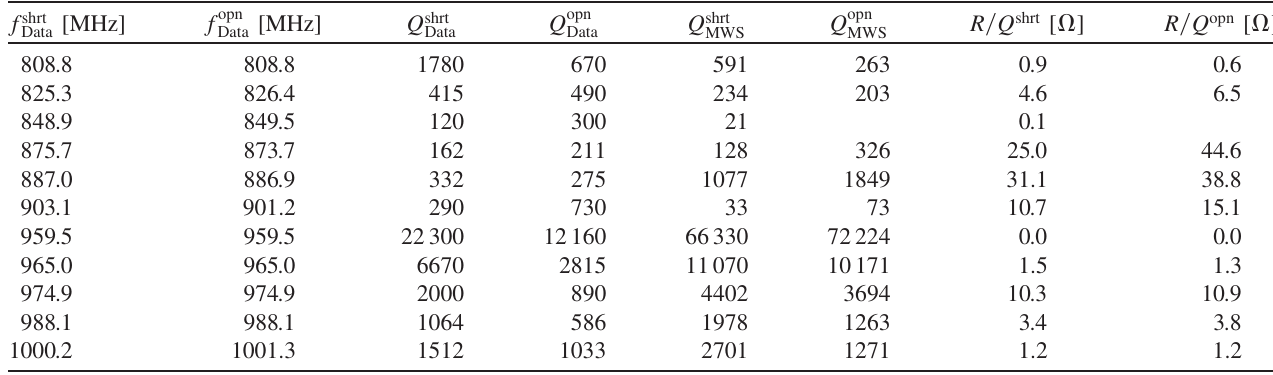
TABLE IV. Measured and simulated results for the shorted and open prototype